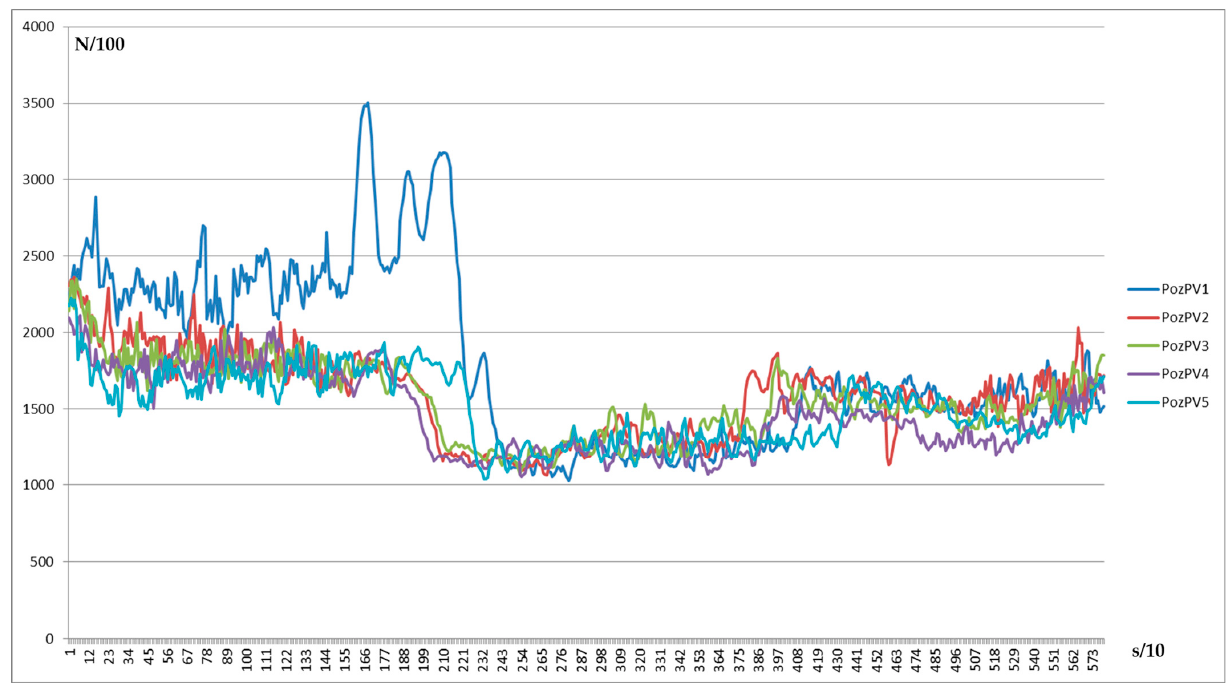
Figure 14. Controlled fiber tensioning results.